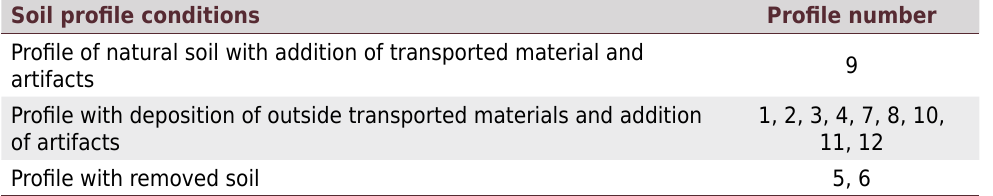
Table 2. Morphological condition of the 12 profiles of urban soils from Santa Maria, Rio Grande do Sul State, Brazil